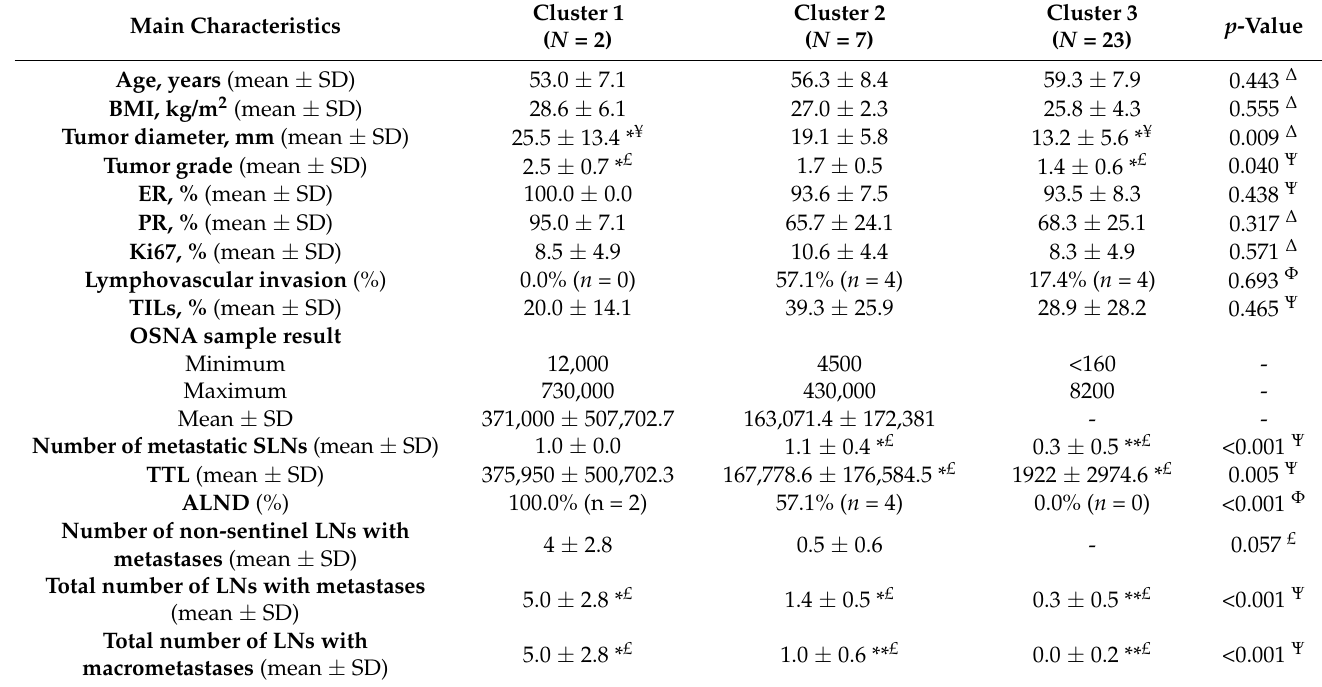
Table 4. Comparison of the main characteristics between the three identified